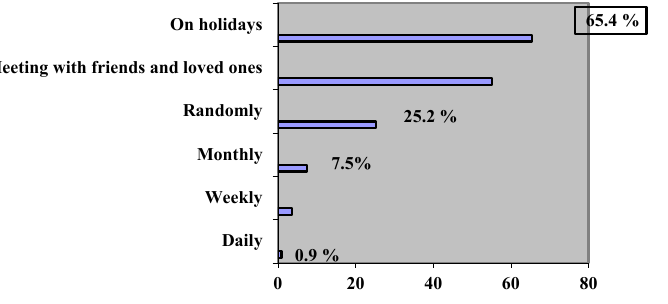
Figure 4. The frequency of consumption of wine products.